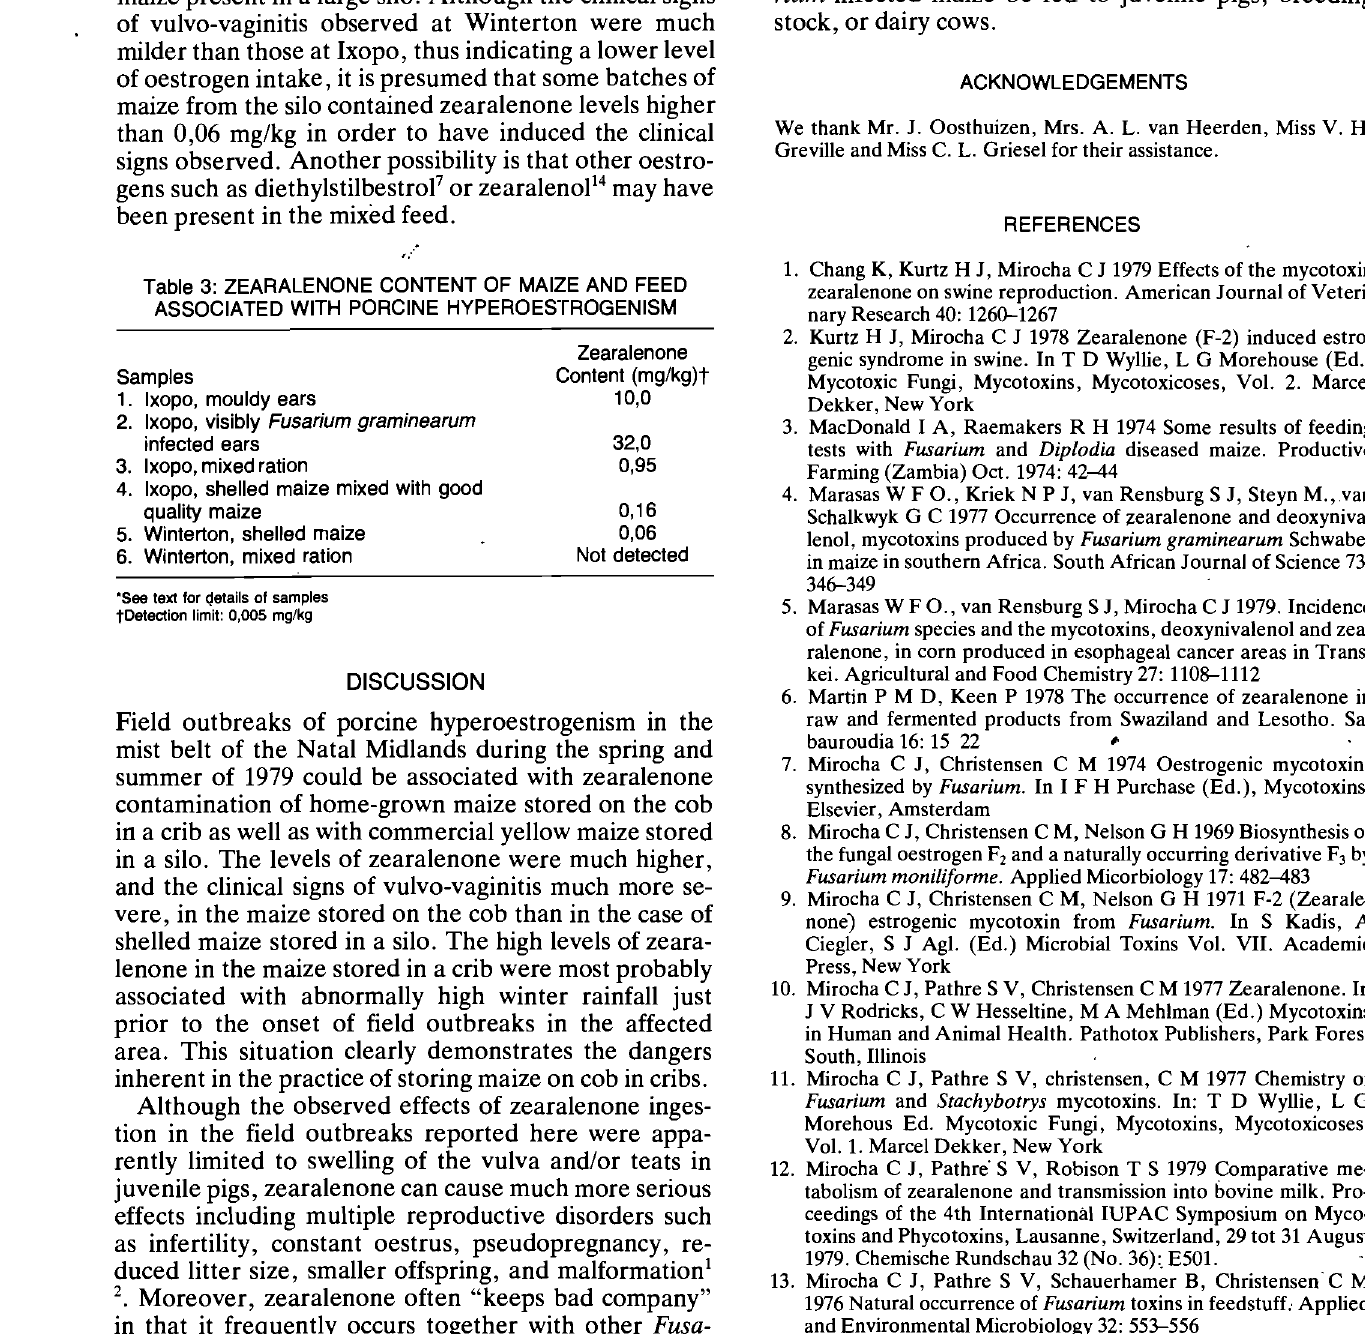
Table 3: ZEARALENONE CONTENT OF MAIZE AND FEED ASSOCIATED WITH PORCINE HYPEROESTROGENISM